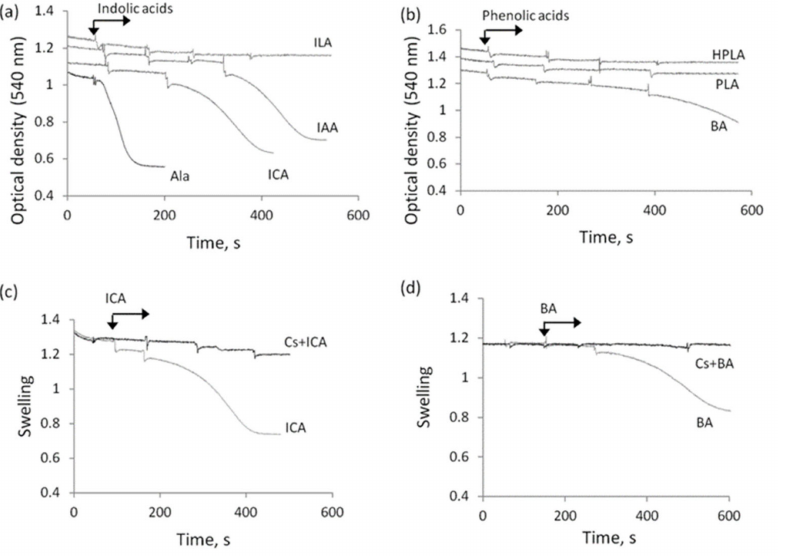
Figure 4. Influence of an excess of indolic and phenolic acids on mitochondrial swelling at neutral pH. Activation of the swelling in the course of successive additions of indolic ( a ) and phenolic ( b ) acids at a concentration of 100 µ M each; the inhibition by CsA of swelling induced by CA ( c ) and BA ( d